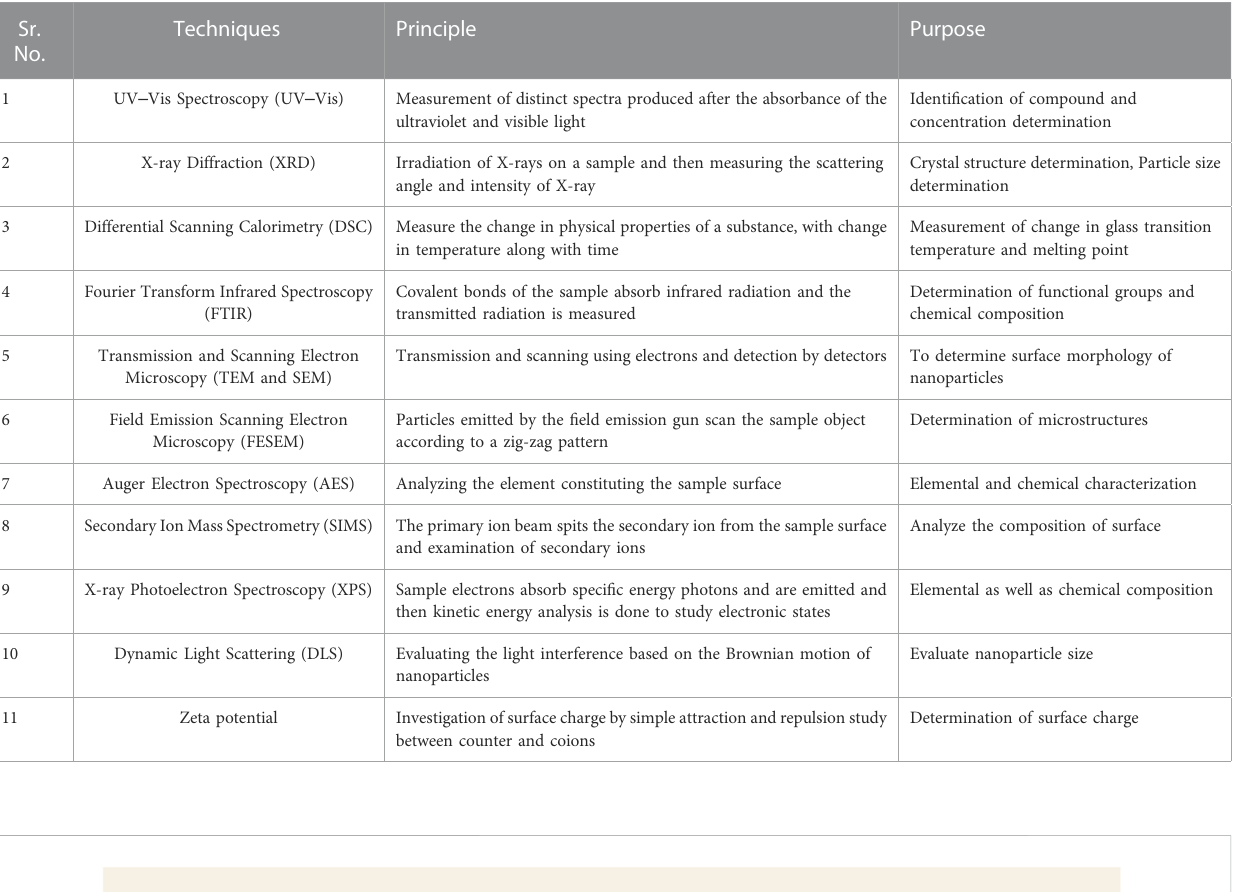
TABLE 2 General characterization techniques for biogenic nanoparticles. Sr. No.